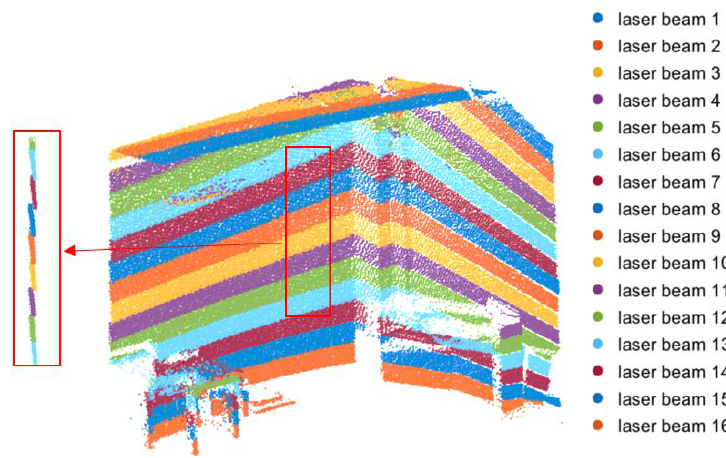
Figure 5. Uncalibrated dense point cloud.